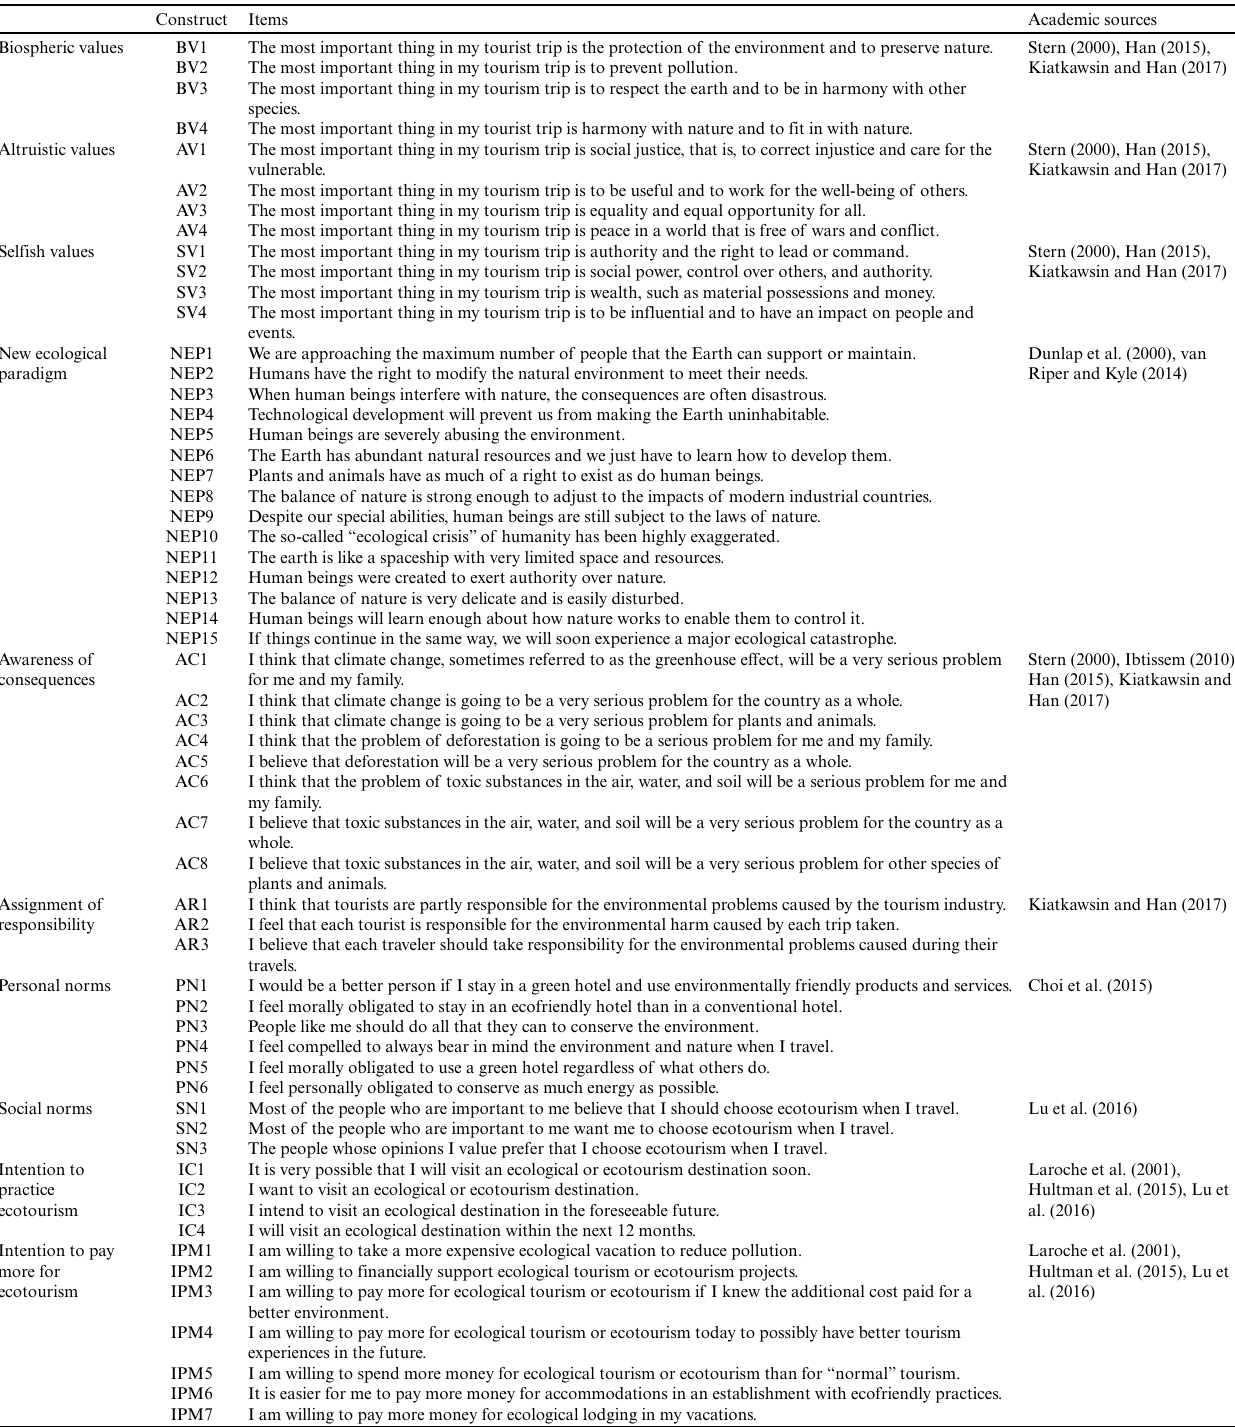
Table 1 . Items included in the model. Construct